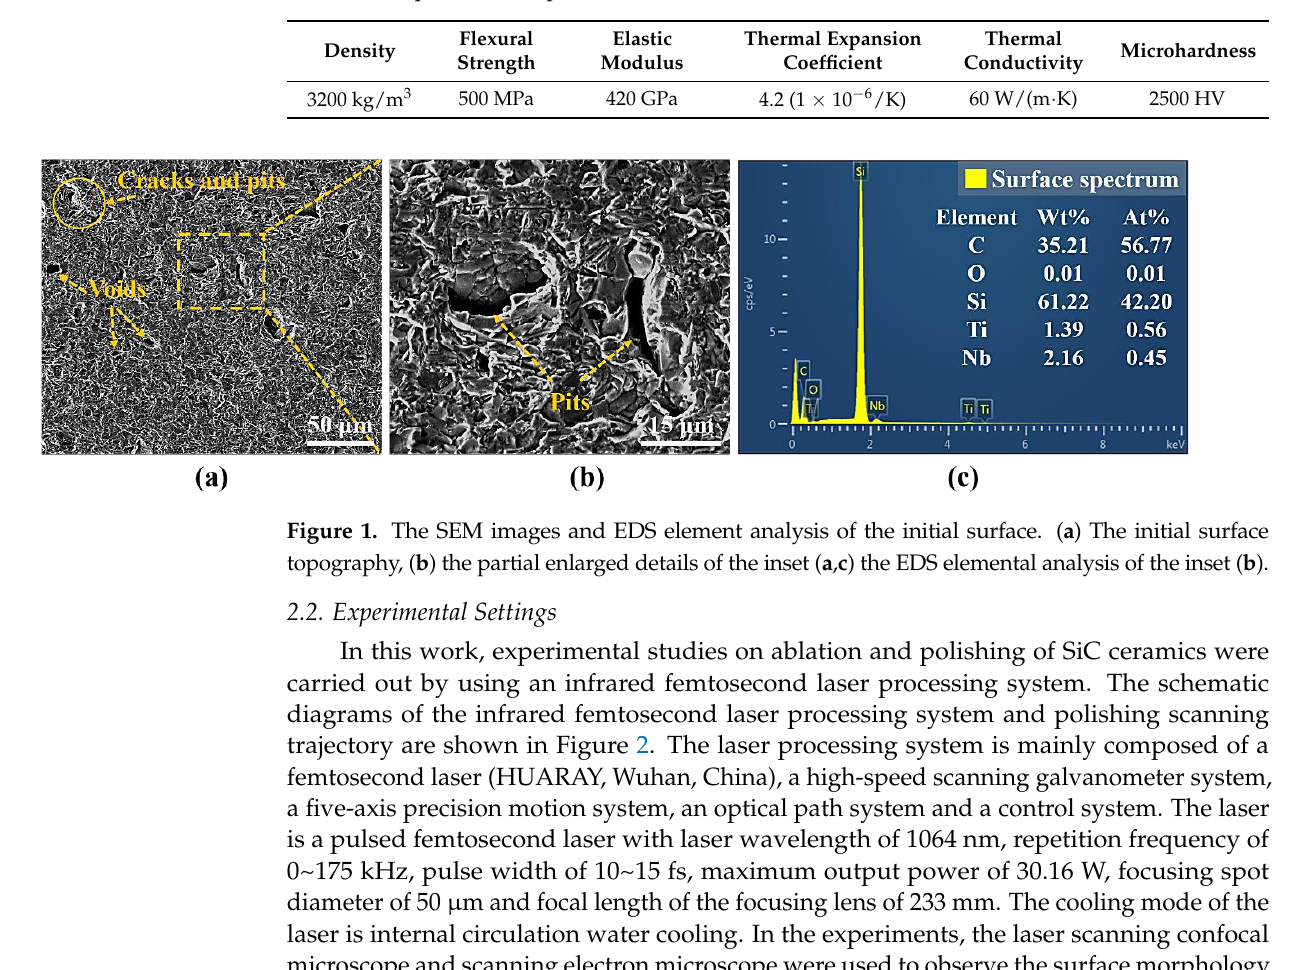
Table 1. The performance parameters of SiC ceramic materials.